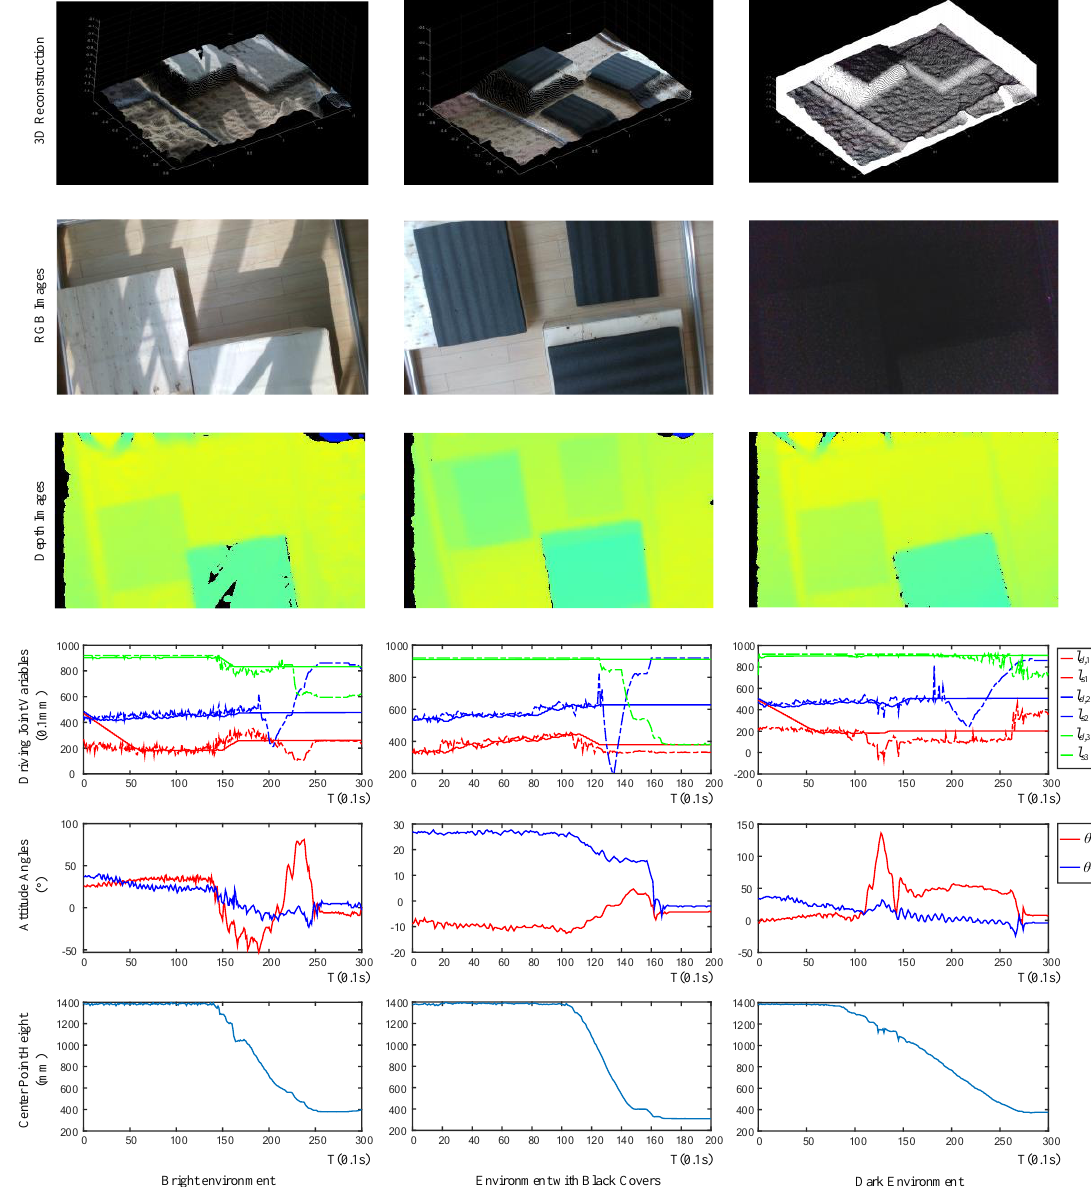
Figure 15. Experiments in different environmental conditions.